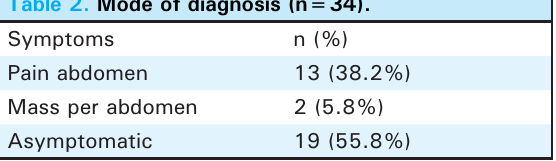
Table 2. Mode of diagnosis (n=34).